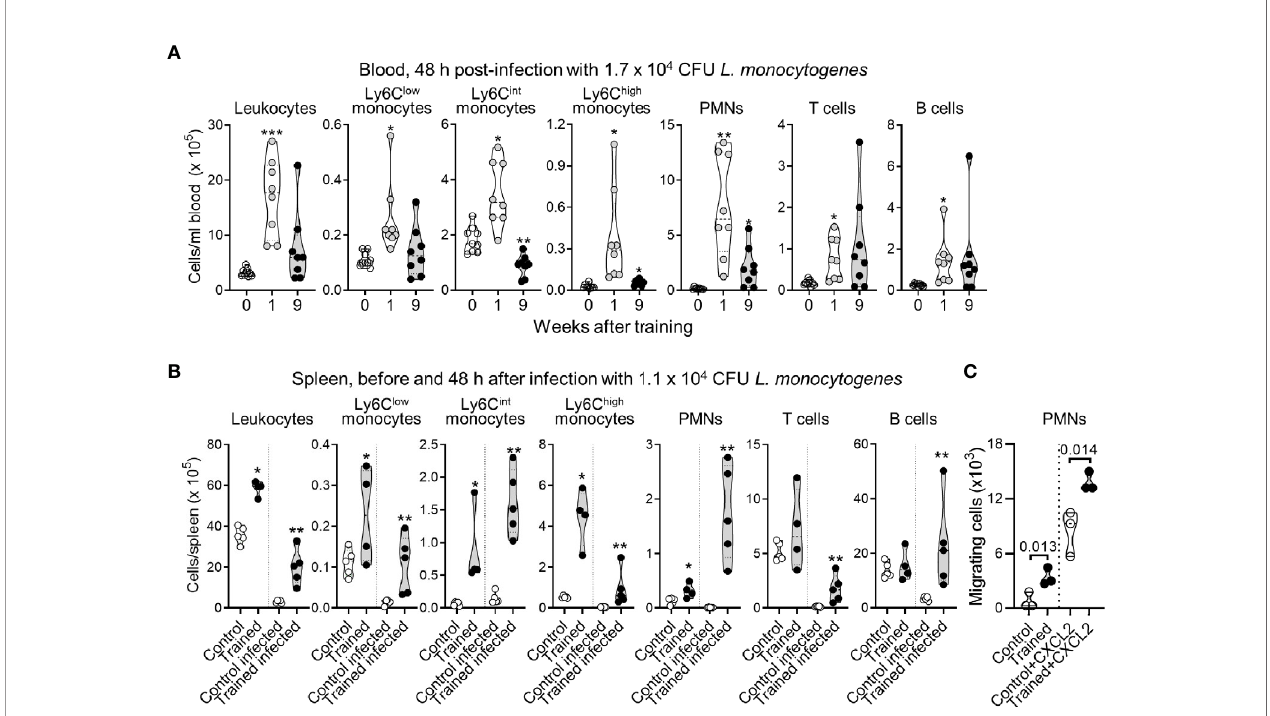
FIGURE 4 | Impact of training on leukocyte counts in blood and spleen during listeriosis. (A) Control mice ( n = 9) and mice trained 1 week and 9 weeks before infection ( n = 8 in each group) were challenged i.v. with 1.7 x 10 5 CFU L. monocytogenes . Blood was collected 2 days after infection to quantify CD45 + leukocytes, Ly6C low , Ly6C lint and Ly6C high monocytes (CD11b + Ly6G - ), PMNs (Ly6G + ), T cells (CD3 + ) and B cells (B220 + ). Each dot in the violin plots represents data from one individual mouse, and the dashed horizontal lines the quartiles. (B) Control mice and mice trained 1 week before infection were challenged i.v. with 1.1 x 10 5 CFU L. monocytogenes . Spleens were collected before infection ( n = 4-5/group) and 2 days after infection ( n = 5 mice/group) to quantify CD45 + leukocytes, Ly6C low , Ly6C lint and Ly6C high monocytes, PMNs, T cells and B cells. Each dot of the violin plots represents data from one individual mouse, and the dashed horizontal lines the quartiles. (C) PMNs were isolated from control mice and mice trained 9 weeks before analysis. Spontaneous and CXCL2-dependent migration of PMNs was measured in transwell assay. CXCL2 was used at 25 nM. Migrating cells were enumerated after 1 h. Each dot in the violin plots represents data from one individual mouse. * P < 0.05; ** P < 0.01; *** P <